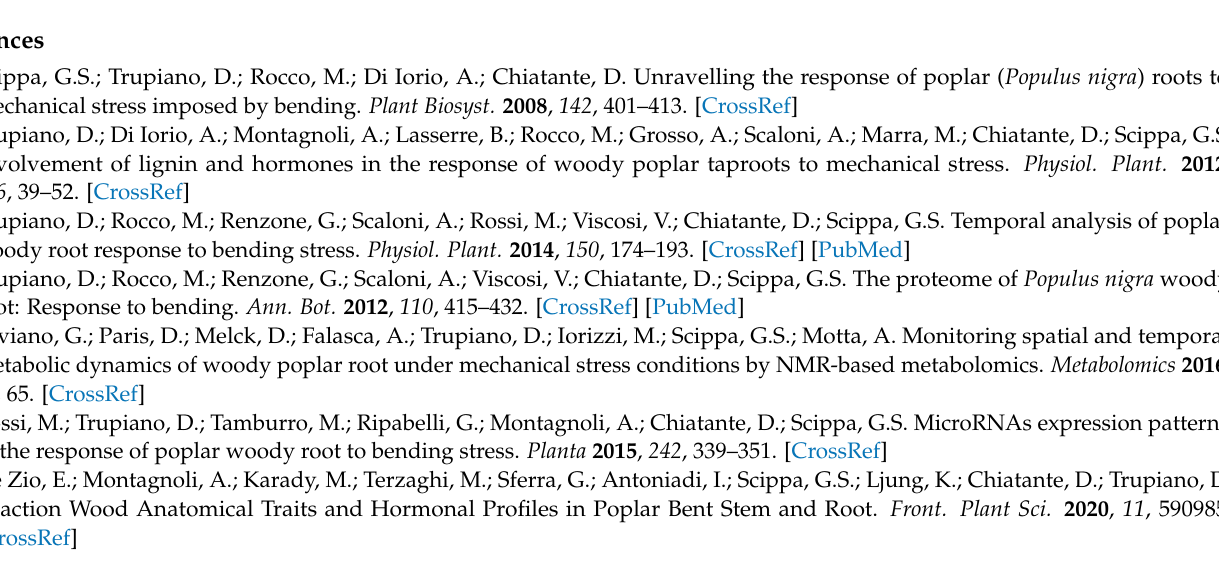
Table S4. Cluster-specific candidate hub genes: results from MCC analysis (cytoHubba) and cross references from UniProt, Blast and